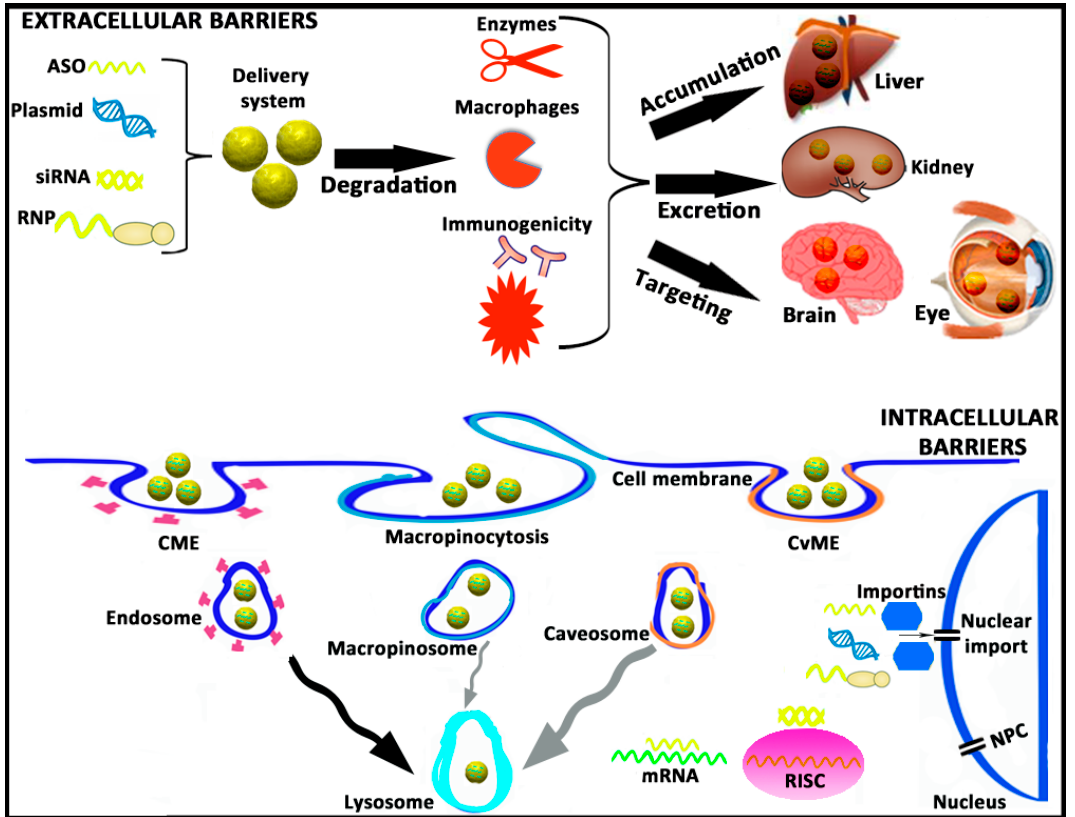
Figure 1. A brief schematic representation of both extracellular and intracellular barriers that genetic material needs to overcome during the transfection process. ASO, antisense oligonucleotide; siRNA, small interfering RNA; RNP, ribonucleoprotein; CME, clathrin-mediated endocytosis; CvME, caveolae-mediated endocytosis; RISC, RNA-induced silencing complex; mRNA, messenger RNA; NPC, nuclear pore complex.